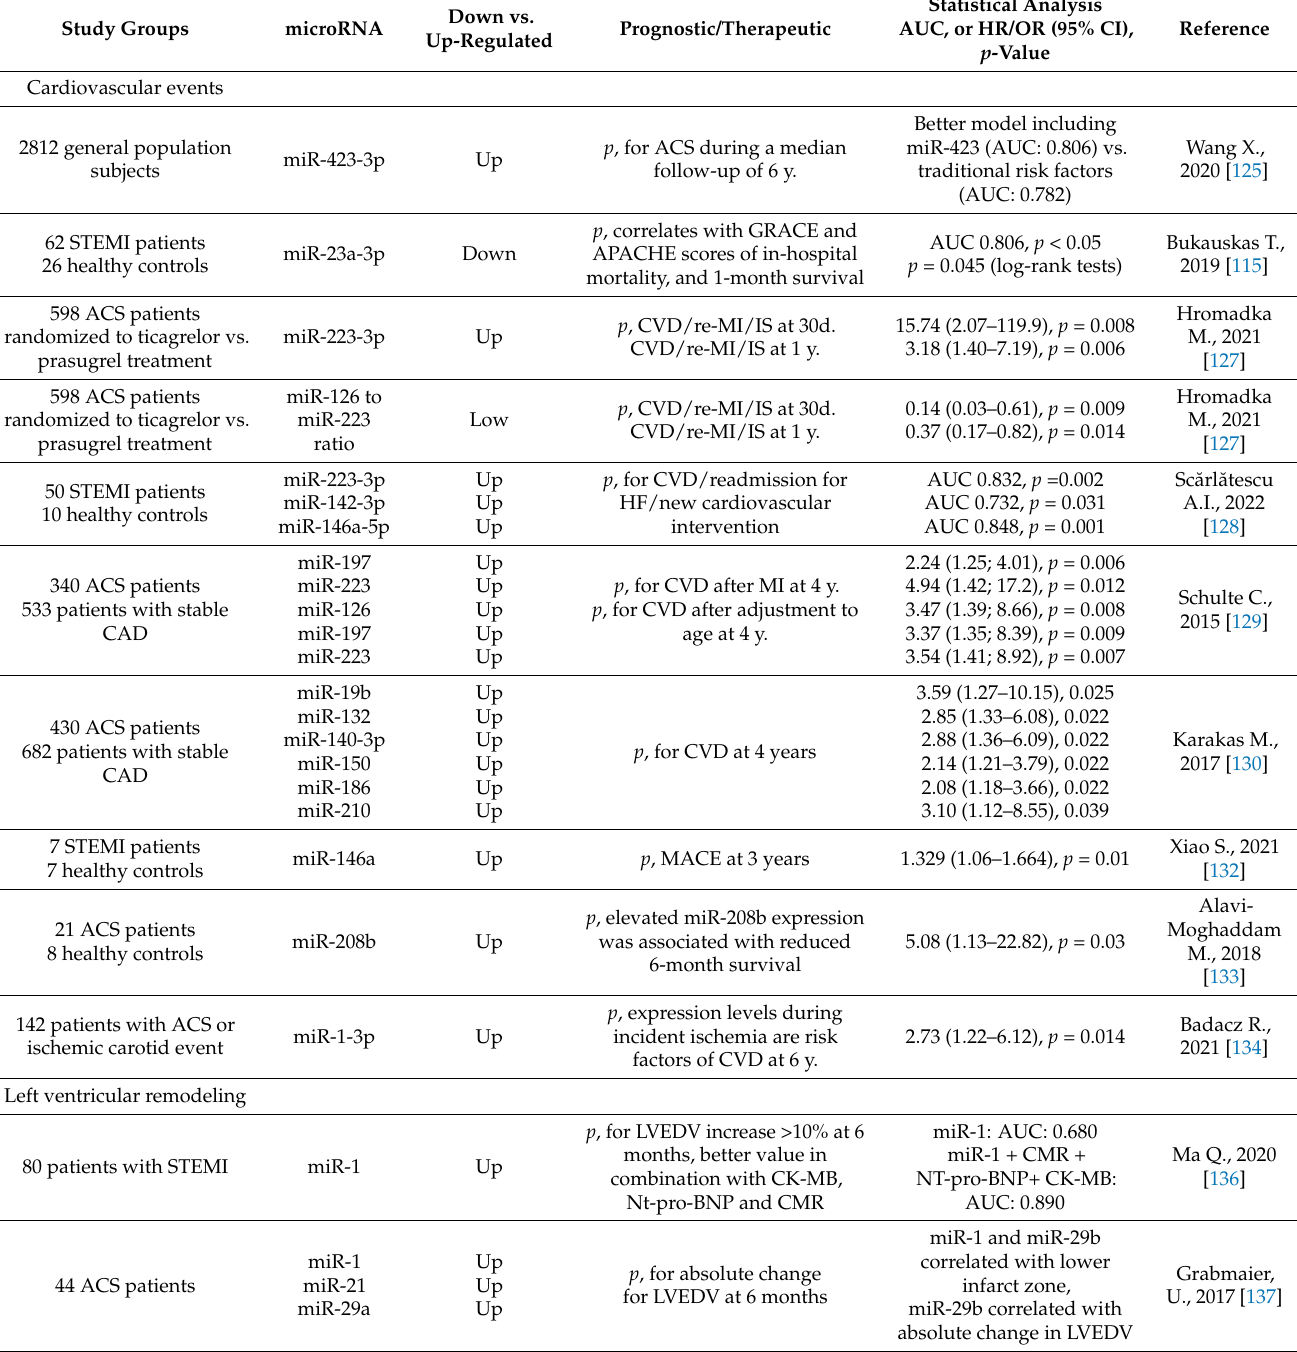
Table 3. microRNAs that may be prognostic biomarkers in stable coronary artery disease and acute coronary syndrome for cardiovascular